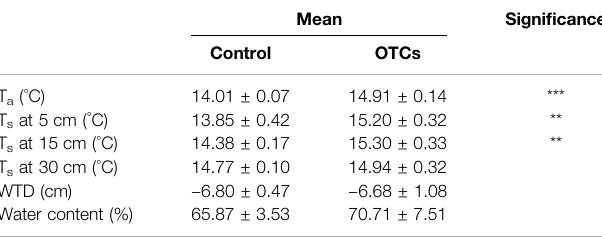
TABLE1| Meanvalueofairtemperature(T a )andsoiltemperature(T s )at5,15,and 30 cm depths of mesocosms, water table depth (WTD), and water content of Sphagnum at 5 cm depth from August 2018 to July 2020. Signi fi cant differences of ANOVA are expressed as * p < 0.05, ** p < 0.01, and *** p < 0.001. Data are presented as mean ± SD, n (cid:2)